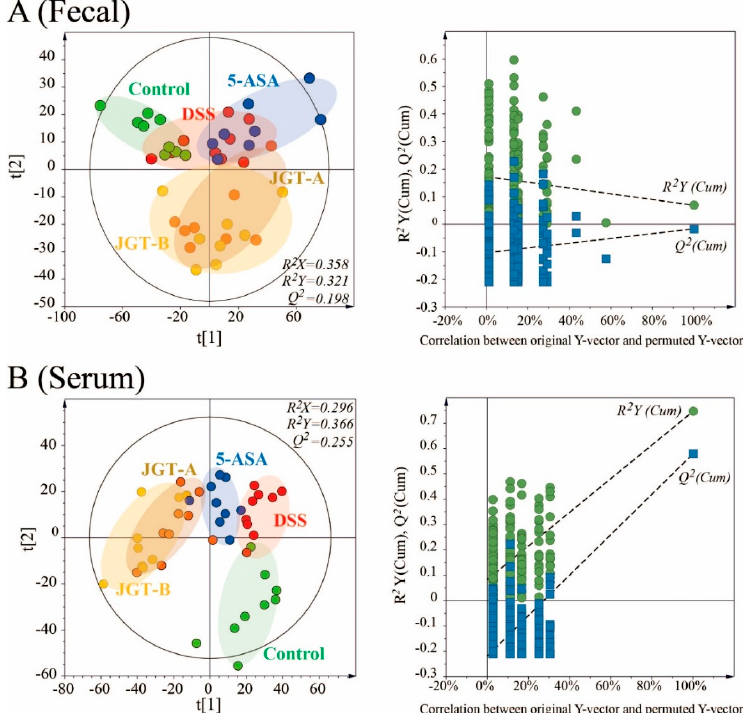
Figure 5. PLS-DA scores plots for control, DSS-induced colitis, 5-ASA, and JGT treated groups derived from GC/MS data of fecal ( A ) and serum ( B ) samples of rats. These PLS-DA models were validated by a permutation test ( n = 200) and CV-ANOVA for assessing reliability.